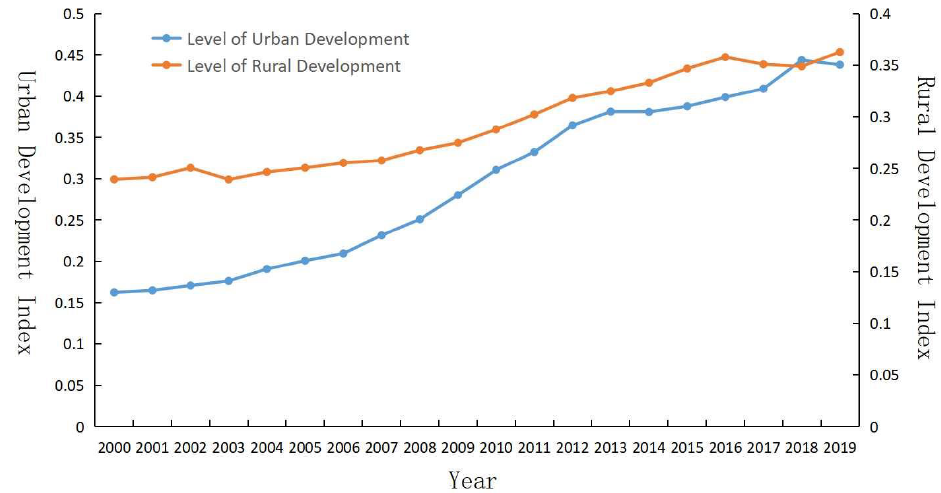
Figure 3. Changes in the Development Levels of Urban and Rural Areas in the Three Northeastern Provinces of China.